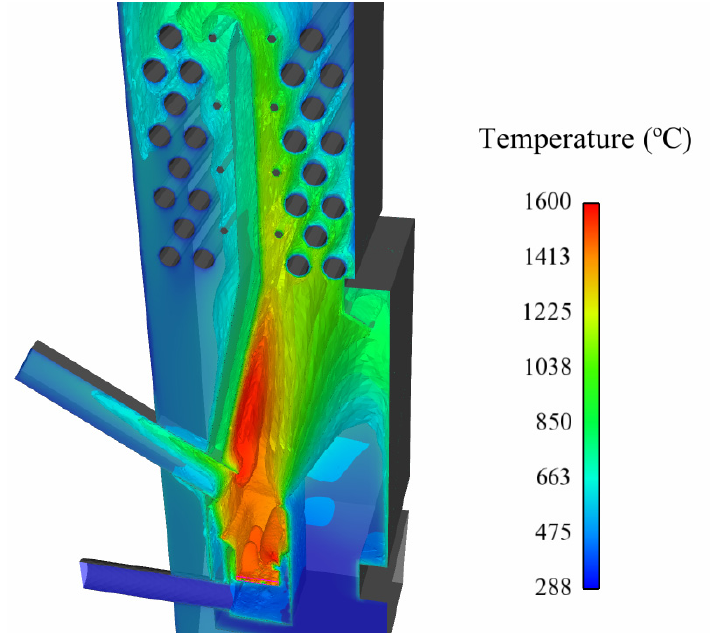
Figure 3. Gas temperature field (°C) in the freeboard and heat exchanger.